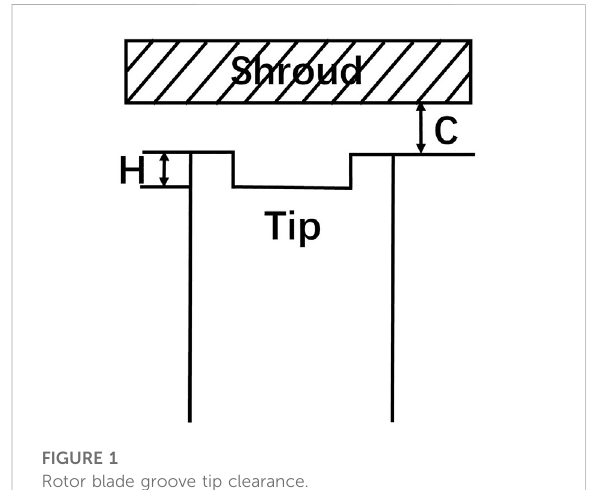
FIGURE 1 Rotor blade groove tip